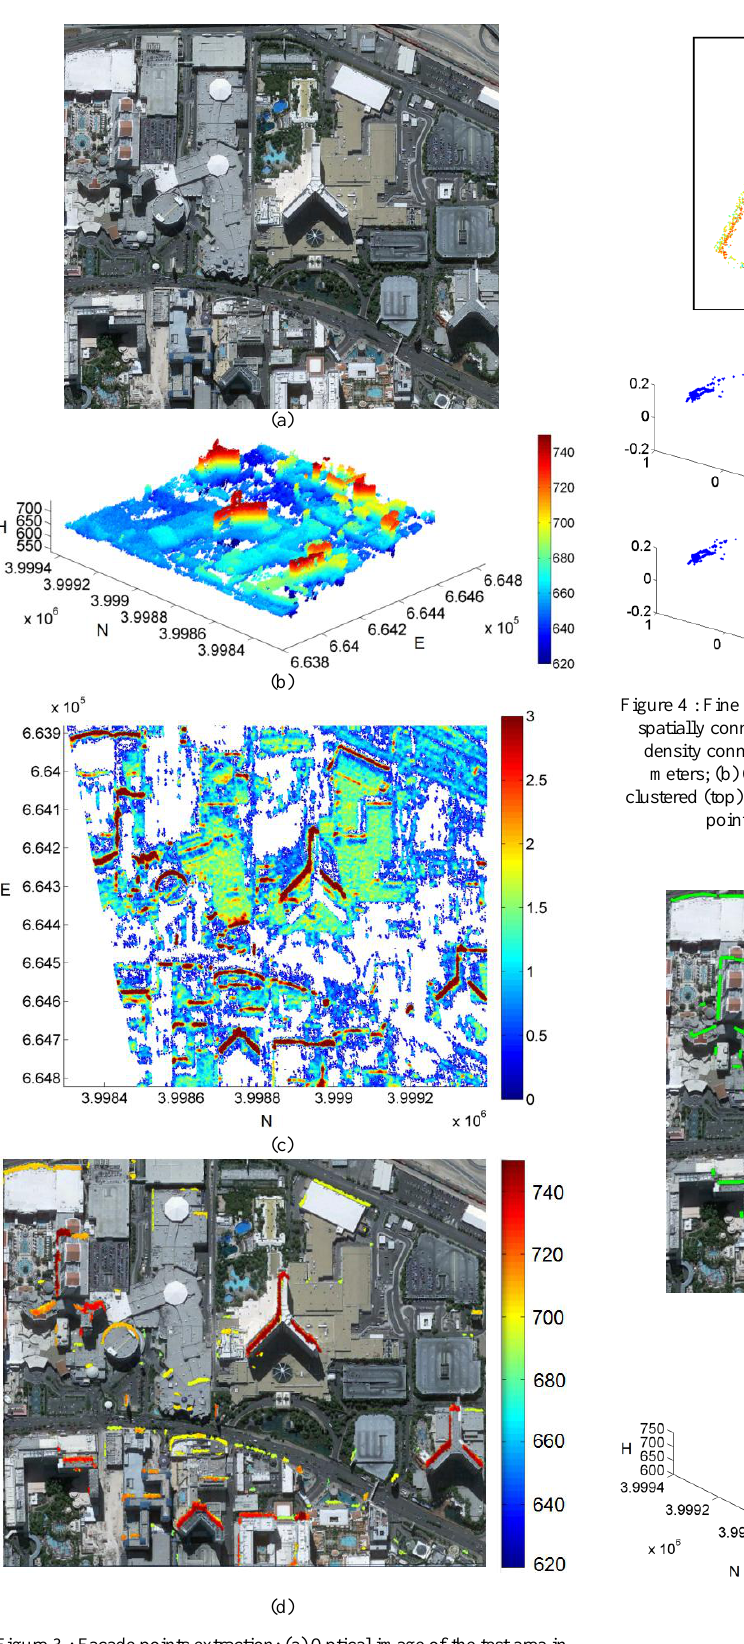
Figure 3 : Façade points extraction: (a) Optical image of the test area in Las Vegas © Google; (b) TomoSAR points in UTM coordinates of the corresponding test image (top view); (c) SD with radius r=5m and Figure 5 : Reconstructed façades: (a)2D view of the façade footprints inliers d=2m; (d) Extracted building façade points. Colobar indicates overlaid onto the optical image; (b) 3D (b)(d) height in meters; (c) SD .